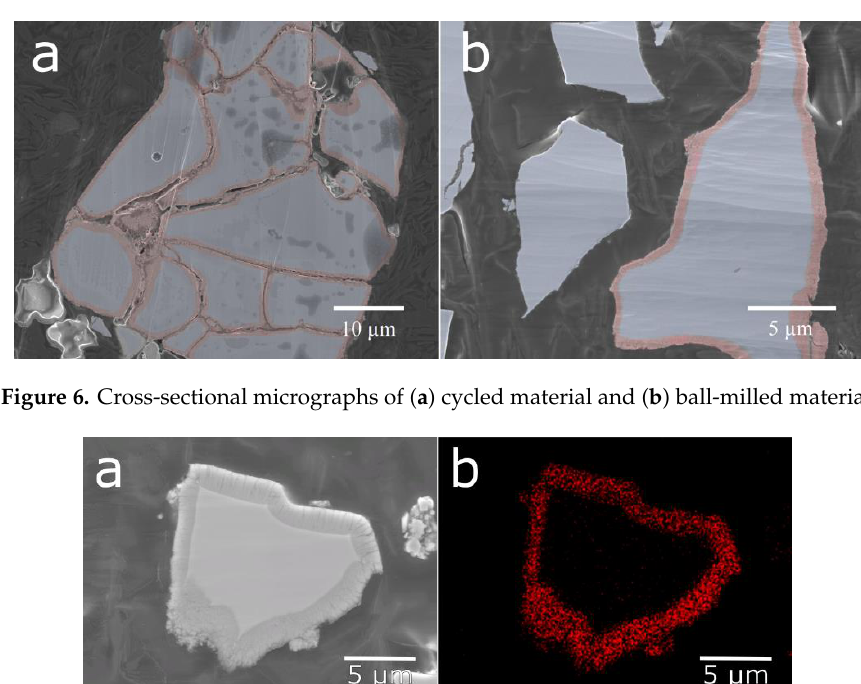
Figure 7. SEM image ( a ) and EDS map with oxygen Kα counts ( b ) of a corroded alloy particle, showing a surface layer with elevated oxygen content.